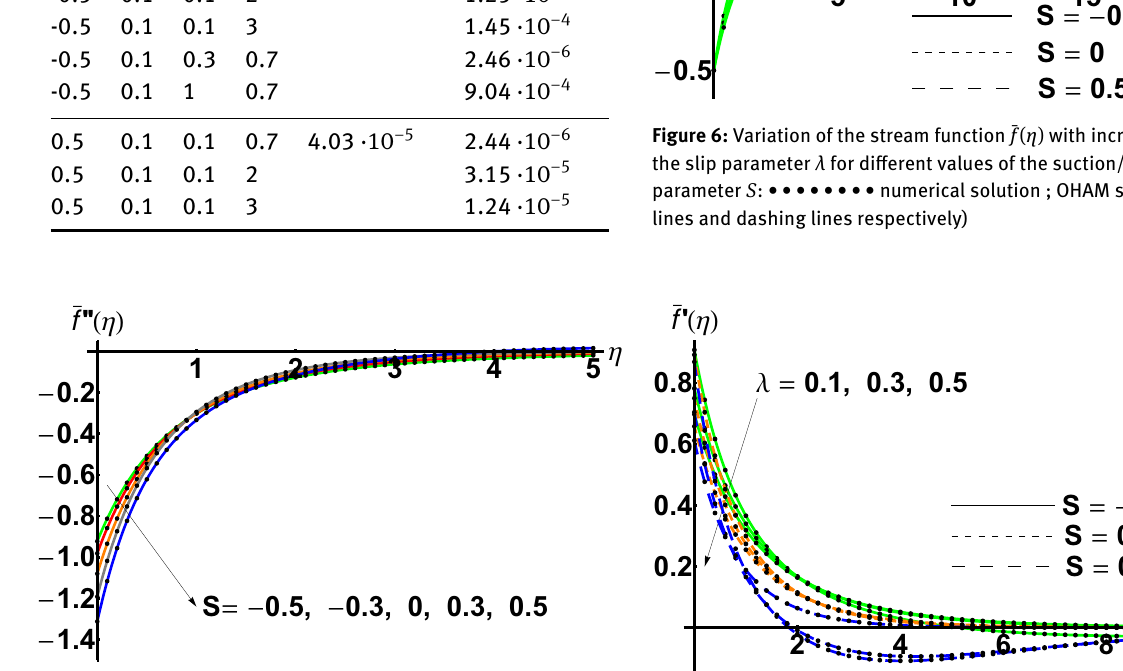
Figure 4: Variation of the shear stress ¯ f ′′ ( η ) with increasing of the suction/blowing parameter S for λ = 0.1 :